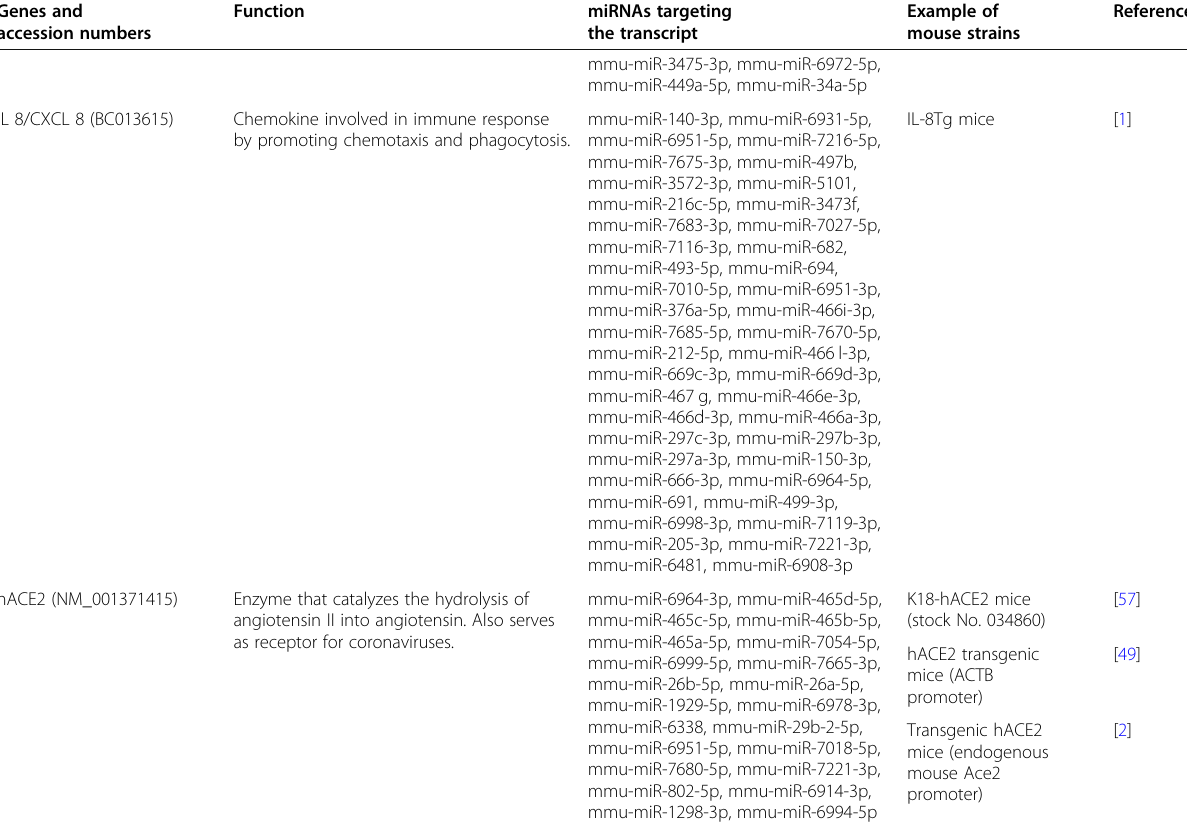
Table 2 Human genes expressed in transgenic mice are targeted by murine miRNAs in corresponding transgenic mice. Human genes expressed in transgenic mice become potential targets of Mus musculus miRNAs due to their foreign nature. This miRNA- target mRNA interaction may often lead to interference with their expression in mice. The potentially targeting miRNAs were retrieved from miRDB using their custom target prediction tool